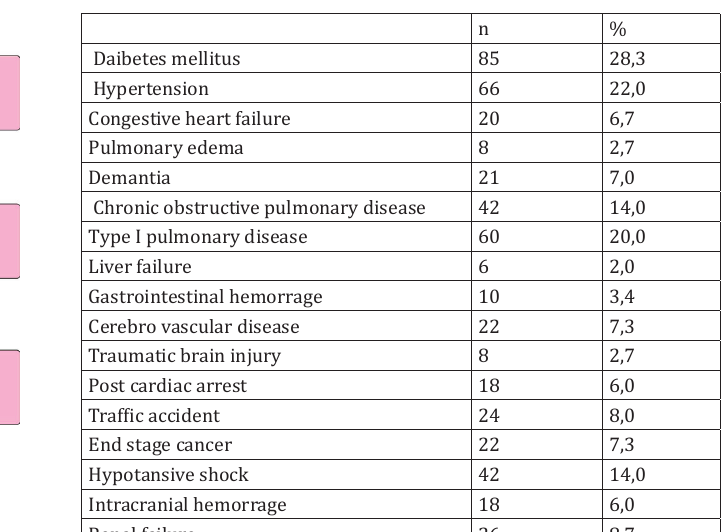
Comorbidities of patients